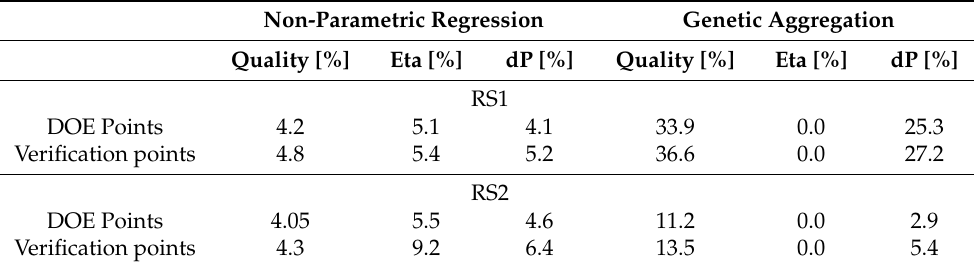
Table 3. RSM goodness of fit: the values of the Relative Average Absolute